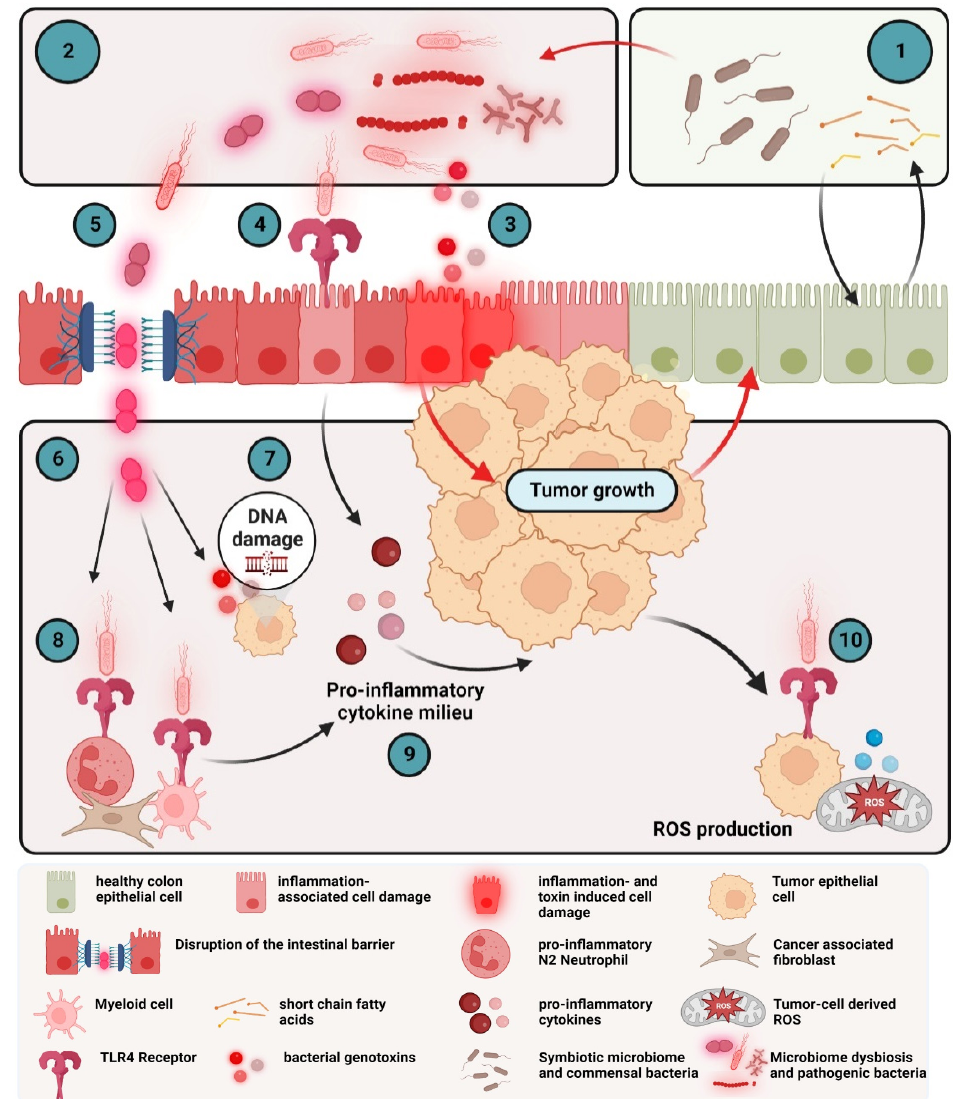
Figure 3. Microbiota-induced pro-inflammatory cytokine milieu in colorectal cancer. The microbiome of a healthy individual is characterized by a high species diversity (1). The microbiome in colorectal cancer is characterized by dysbiosis with an overrepresentation of pathogenic bacteria and their metabolites (2). Bacterial metabolites can induce hyperactivation of the WNT- β -catenin pathway and secretion of TNF and IL-17 in epithelial cells (3). Bacteria interact with gut epithelial cells via pattern recognition receptors such as TLRs. Activation of TLRs by PAMPs leads to expression of pro-inflammatory cytokines such as IL-1 β (4). Some pathogenic bacteria increase the intestinal permeability (5), leading to the translocation of bacteria (6) Bacterial metabolites of the invading bacteria induce DNA damage and, thus, direct mutagenic effects (7). Myeloid cells sense bacterial products via TLR and produce several pro-inflammatory cytokines, such as IL-6, TNF or IL-17, that further promote tumor growth (8 and 9). Binding to TLR4 on tumor cells leads to ROS production, further promoting the circulus vitiosus between dysbiosis, invasion, inflammation and tumor growth (10). The cytokine IL-6 is involved not only in cancer inflammation but also in hematopoiesis, bone metabolism and embryonic development [92]. The IL-6R is composed of the binding receptor chain IL-6Ra and the signal transducer chain glycoprotein 130 (gp130). As IL-6 is a target of the transcription factor NF- k B, the activation of NF- k B by, e.g., TNF, simultaneously with the activation of signal transducer and activator of transcription 3 (STAT3) in non-immune cells such as epithelial cancer cells, triggers a positive feedback loop by the IL-6-signal transducer and activator of transcription 3 (STAT3) axis [68]. The resulting excessive activity of IL-6 leads to the overexpression of the proto-oncogene c-Myc, multiple pro-inflammatory